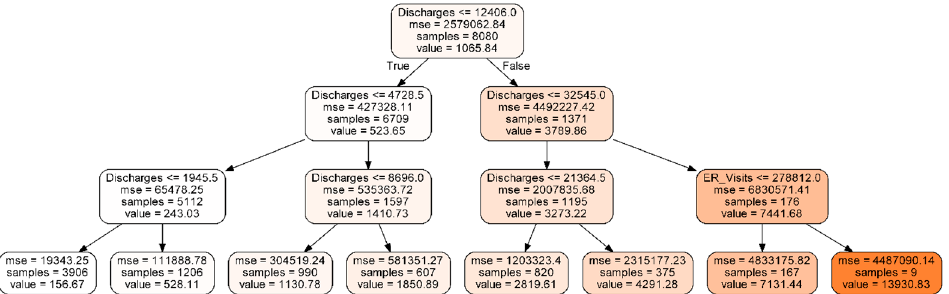
Figure 1. An example of a tree model to classify opioid admissions